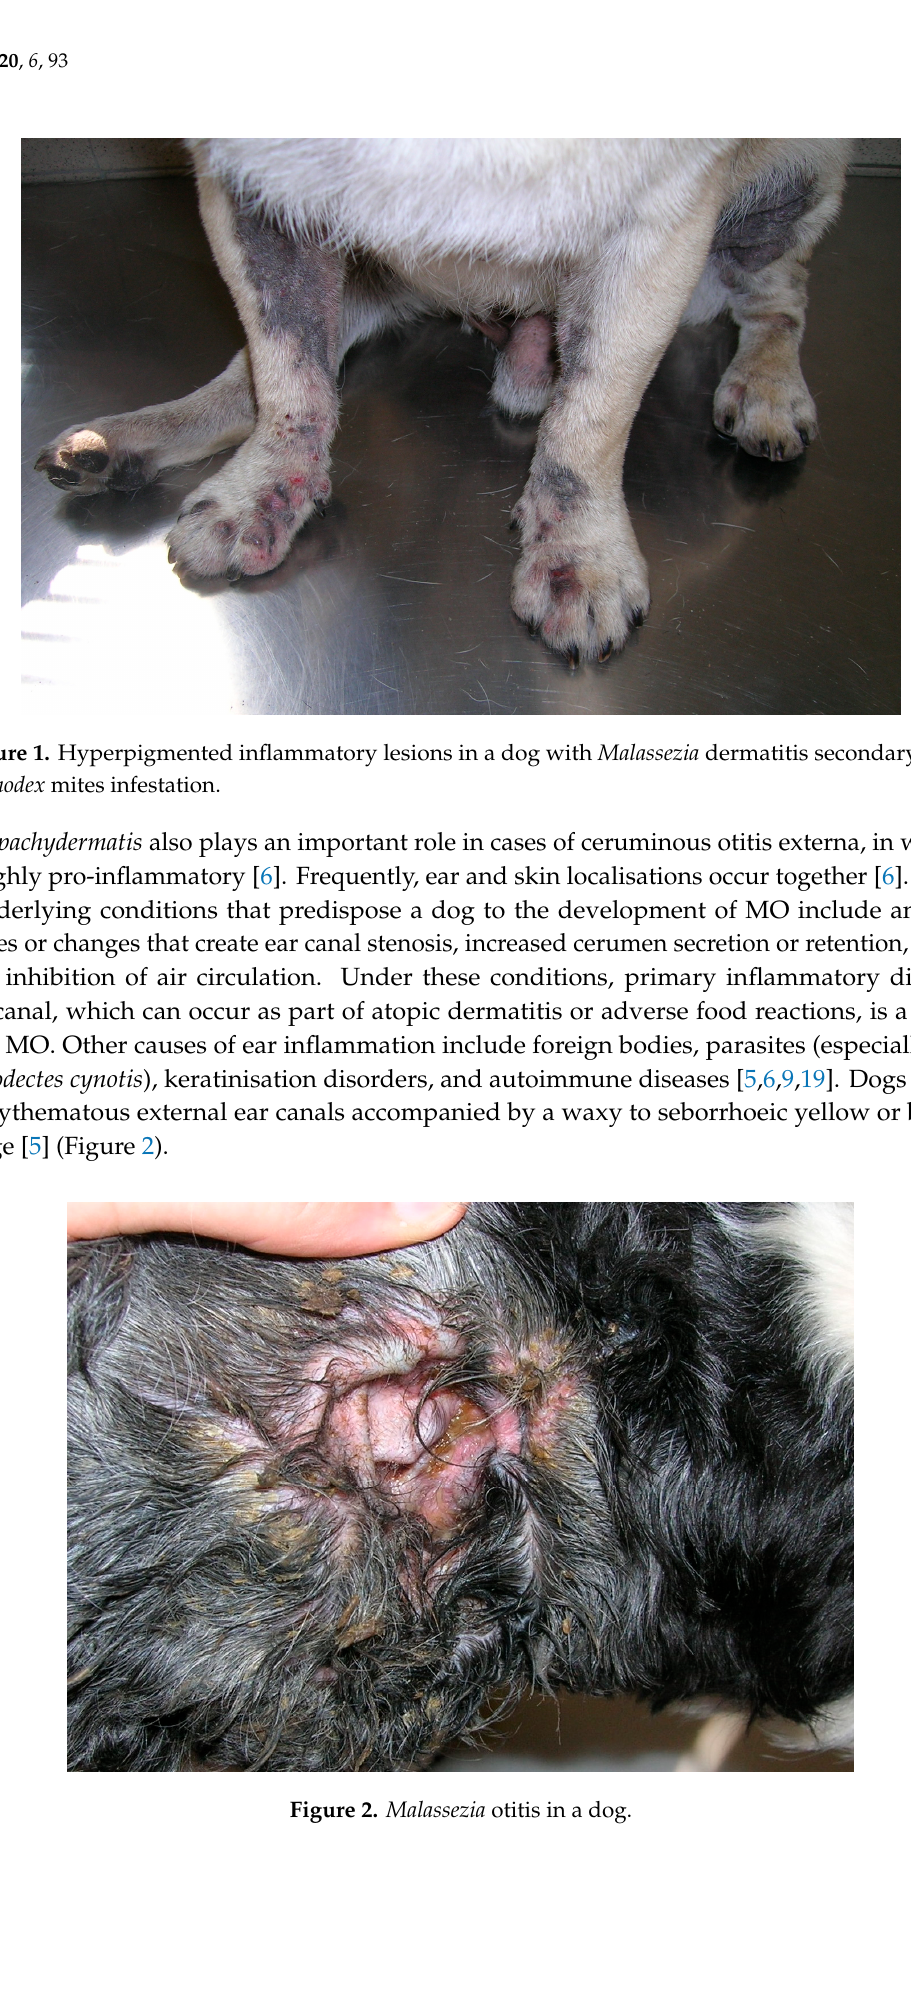
Figure 3. Skin cytology from a dog with Malassezia dermatitis. Numerous typical peanut-shape budding yeasts (1000-fold magnification, Hemacolor ® rapid staining kit) . Table 1. Antifungal agents used to treat Malassezia dermatitis and otitis in the dog. Mechanism of Action